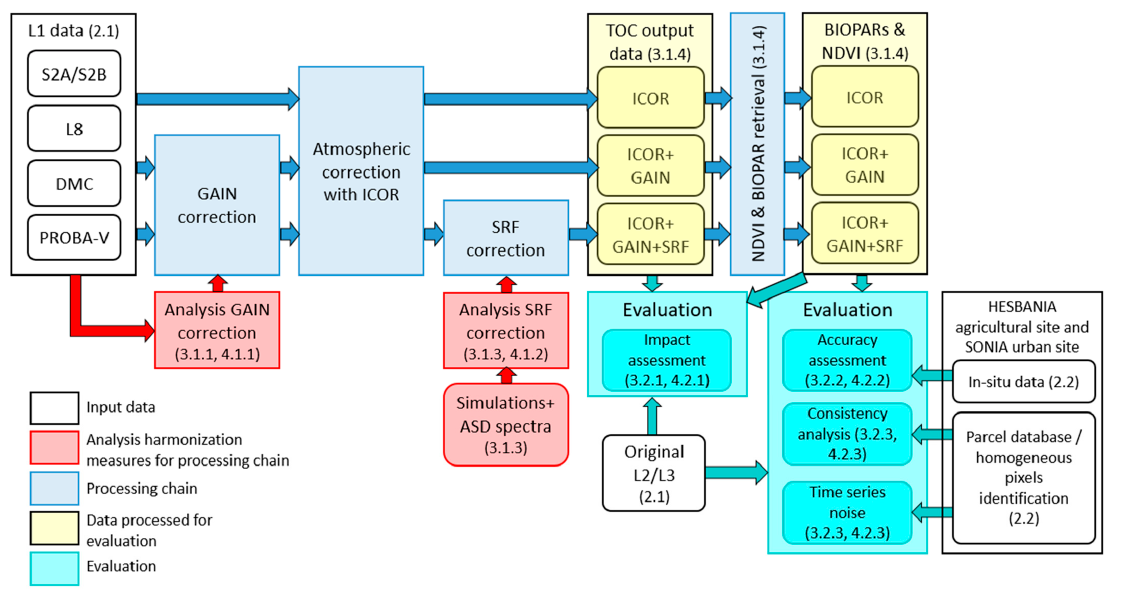
Figure 2. Overall flowchart of the work performed. Numbers indicate the section numbers in the paper. Colours indicate the different parts of the work: white, input data; red, analysis of harmonization measures performed to set up the processing chain; blue, the processing chain; yellow, the processed data sets for evaluation; cyan, the evaluation performed to answer the research questions formulated in the Introduction (Section 1).